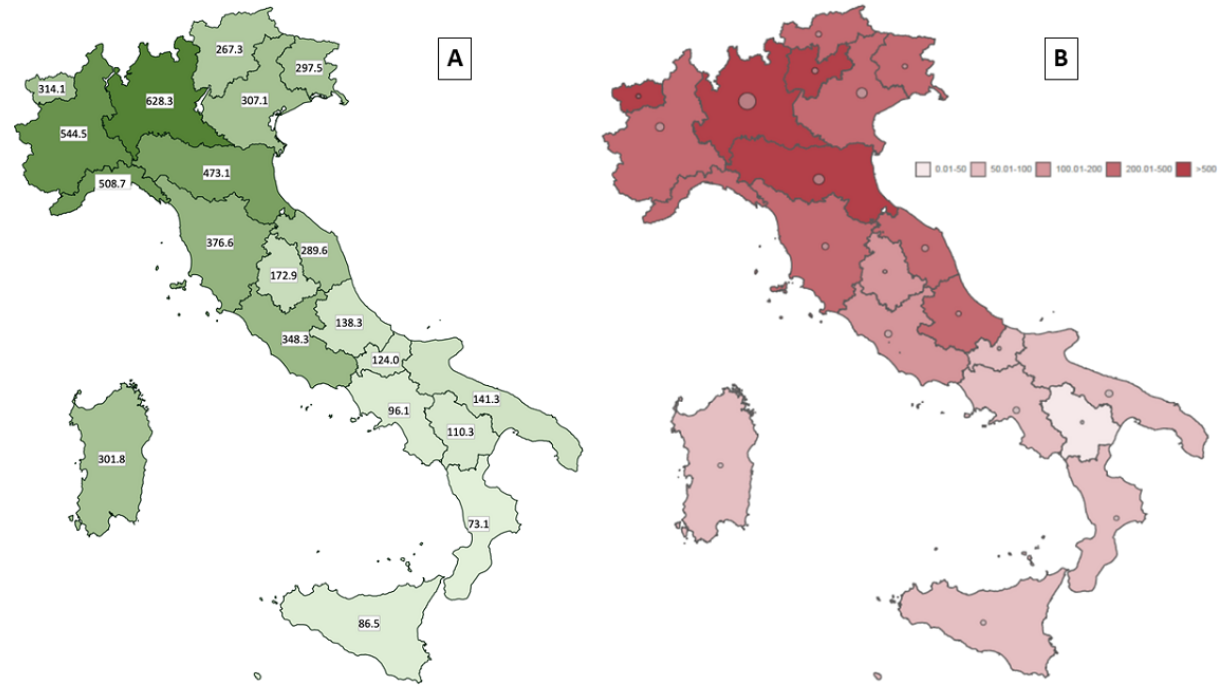
Figure 1. Comparison of the survey response rates and the incidence of severe acute respiratory syndrome coronavirus 2 (SARS-CoV-2) infection